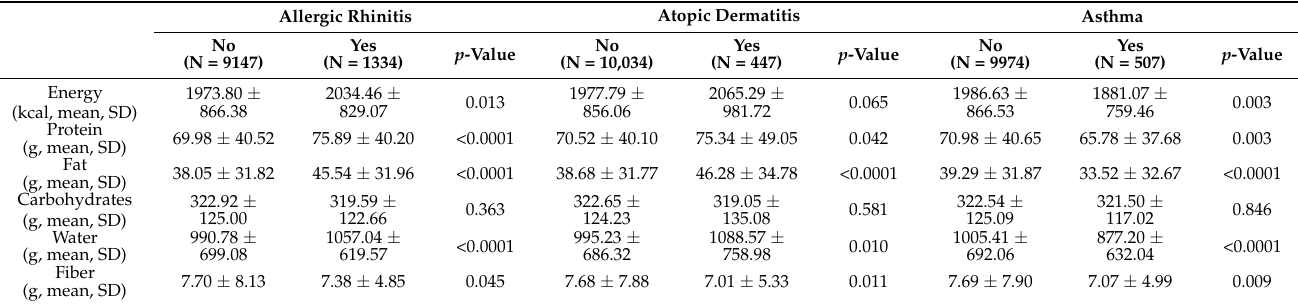
Table 1. Comparison of daily nutritional intake according to the presence of allergic rhinitis, atopic dermatitis, and asthma with nutrients. Allergic Rhinitis Atopic Dermatitis Asthma